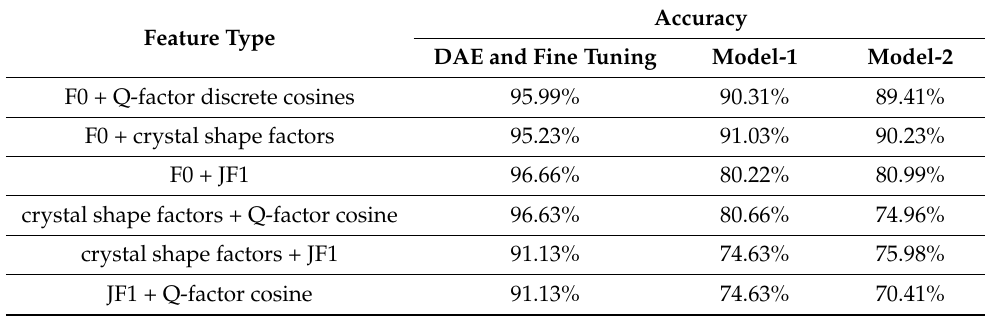
Table 14. Comparison of Model-1, Model-2 and our model proposed with Double Feature Groups.